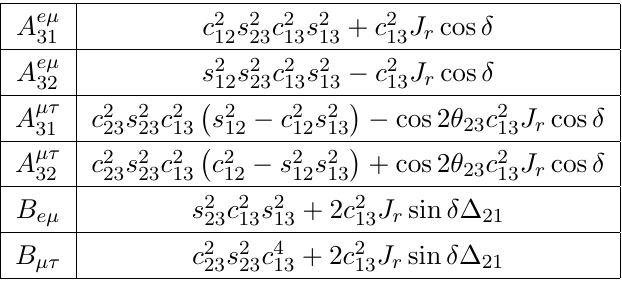
Table 1 . The coe(cid:14)cients A e(cid:22) etc. used in eq. (6.1) are tabulated. The similar expressions for other 31 channel, e.g., A e(cid:28) can be obtained by the appropriate transformation from A e(cid:22) 31